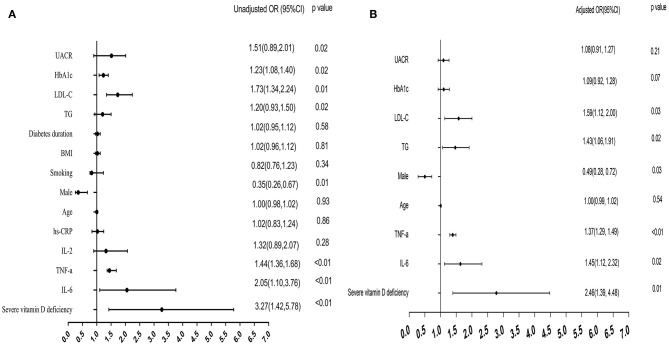
Forest plots for multivariate logistic analysis of variables for painful DPN. (A) Univariate logistic analysis: unadjusted odds ratio (OR) for each variable. (B) multivariate analysis: adjusted OR after adjustment for age, gender, HbA1c, TG, LDL-C, and UACR. DPN, diabetic peripheral neuropathy.